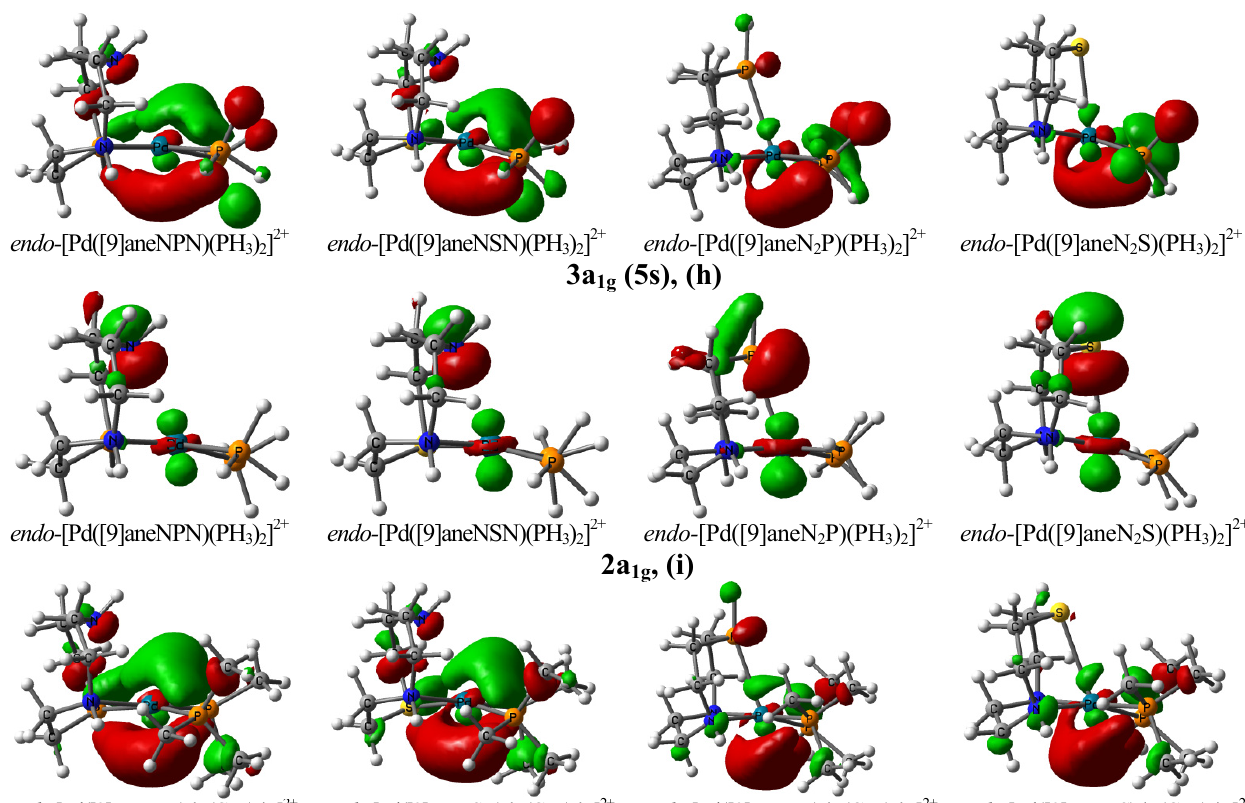
Pd([9]ane B A ) L and endo -Pd([9]ane BAB ) L 2 2 311+G** (lanl2DZ for Pd) level,